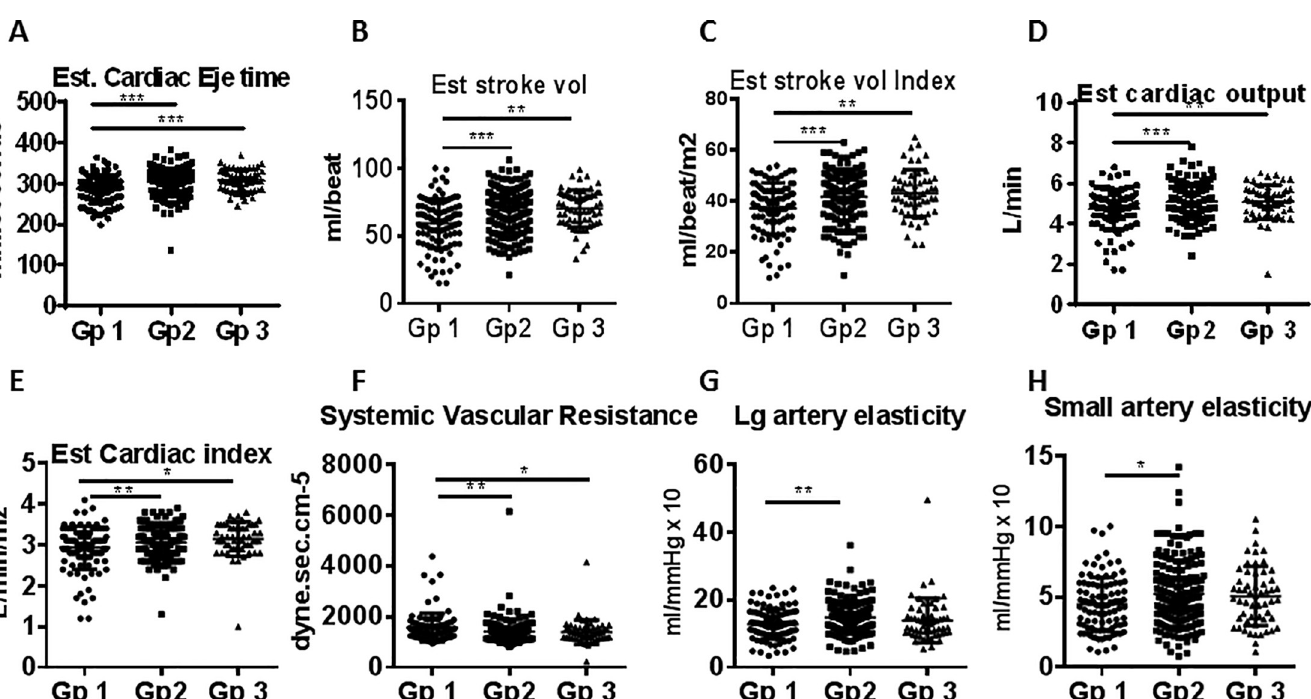
Fig 4. Cardiac functions are impaired in HIV+ ART naive group. Cardiac function and arterial stiffness related measures were compared between ART na ï ve (Gp1) and virologically suppressed on-ART (Gp2) patients and healthy controls (Gp3). Measures of cardiac functions include A), estimated cardiac ejection time; B), estimated stroke volume; C), estimated stroke volume index; D), estimated cardiac output and E), estimated cardiac index. F-H: Measures of arterial stiffness include F), systemic vascular resistance, G), large artery elasticity index and H), small artery elasticity index. Data between groups are compared using Wilcoxon rank-sum test; a p value of < 0.05 was considered significant. � p < 0.05; �� p < 0.01; ��� p < 0.001; ���� p <